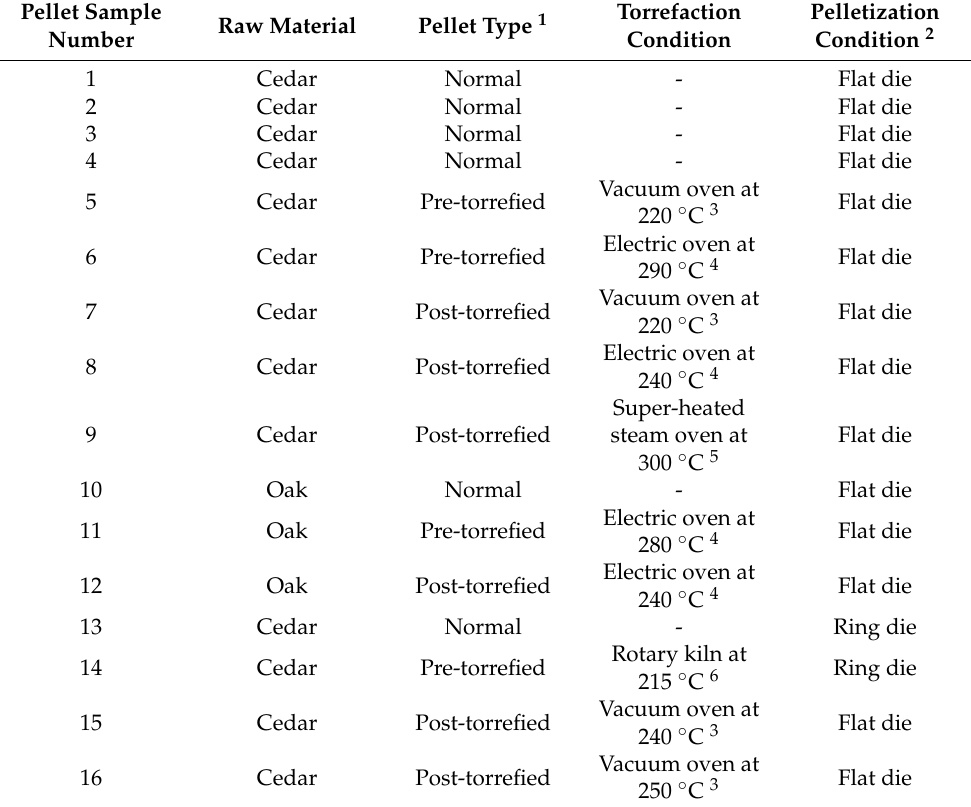
Table 1. Wood pellets used in this